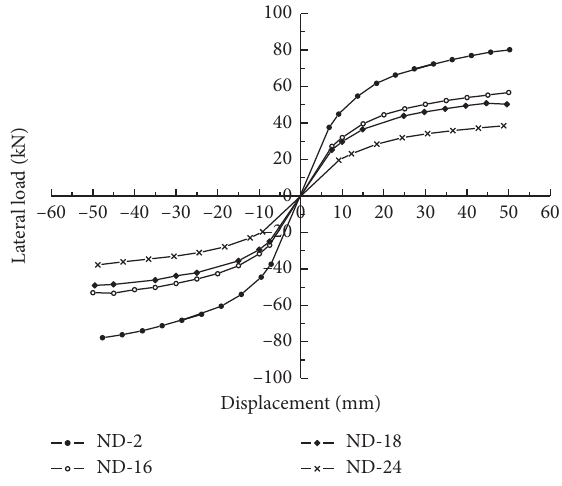
Figure 13: Skeleton curves of different slit width. Table 5: Loads, displacement, and ductility of different slit width.